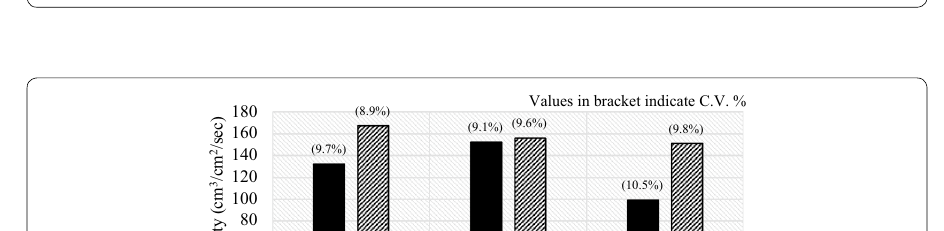
Fig. 6 Elongation % of cross laid (60:40) banana nonwoven fabric